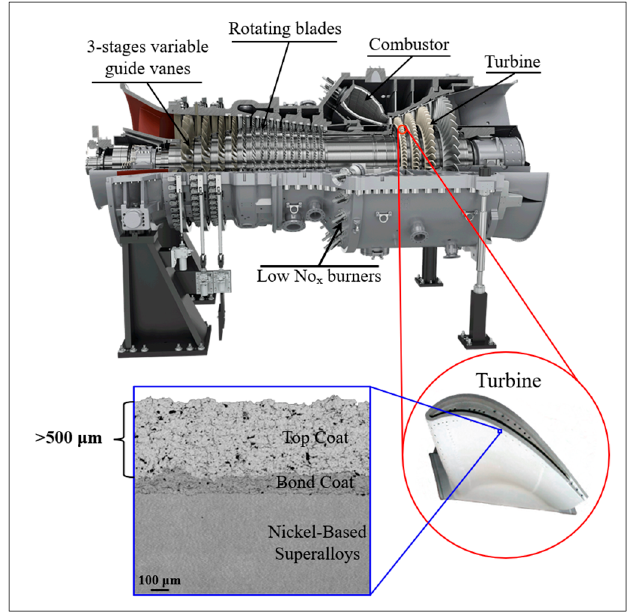
Figure 5. Cutaway view of gas turbine SGT5-4000F, TBC on the first stage blade, and SEM image of TBC cross-section obtained by APS 8 wt % yttria-stabilized zirconia (8YSZ). (Engine from Siemens energy, turbine images from SULZER W501F, and SEM micrographs adapted from Ref. [45] ).